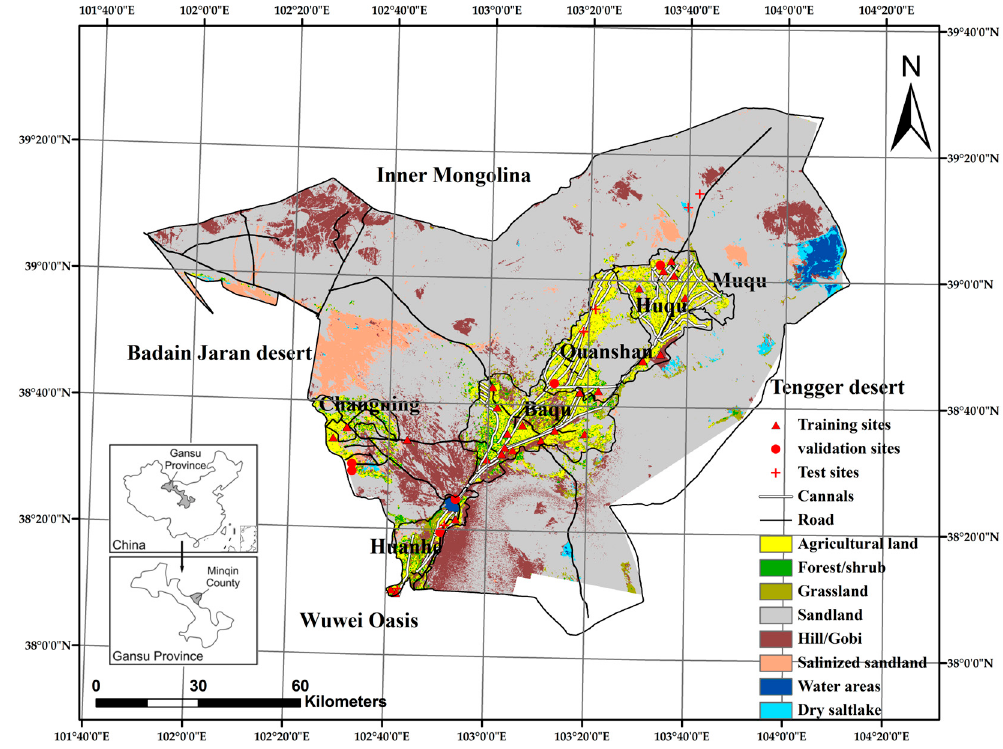
Figure 1. The 2008 land use and 2010 field sites in the study area.